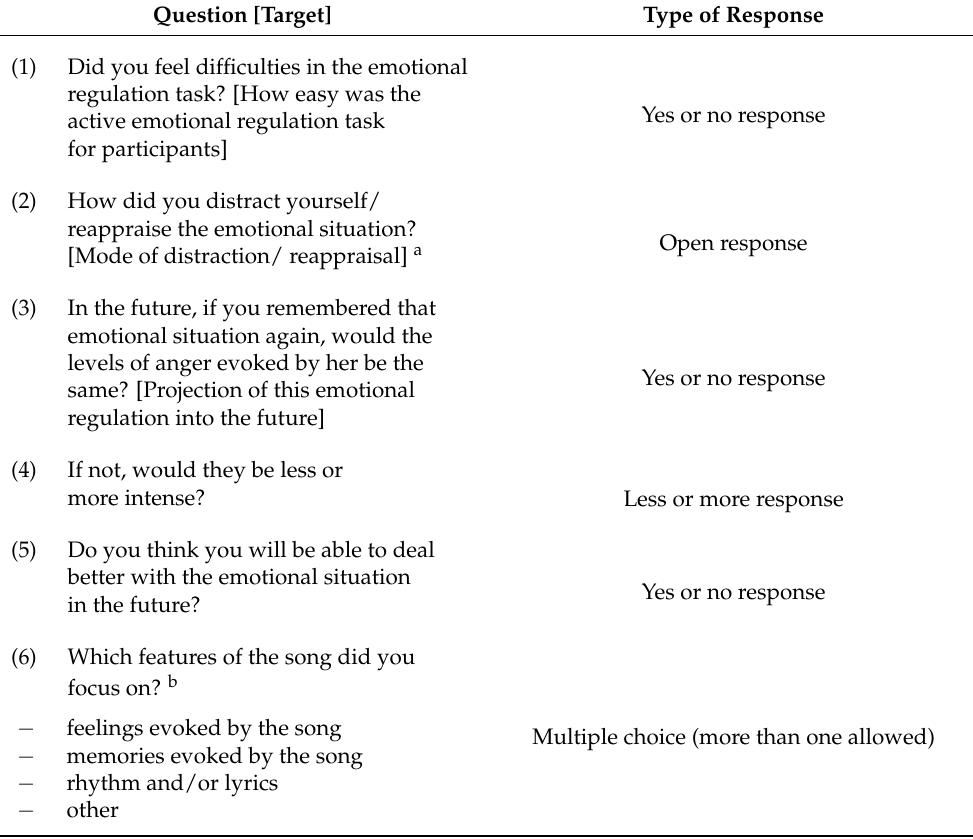
Table 1. Questionnaire on subjective perceptions of the regulation